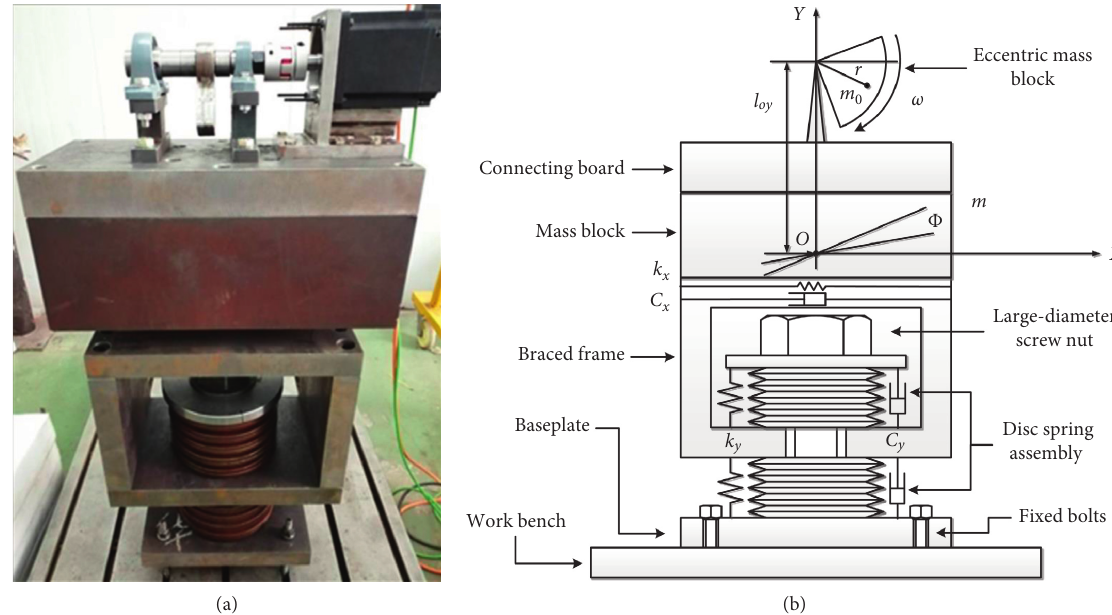
Figure 1: Disc spring vibration system: (a) experiment model and (b) structural